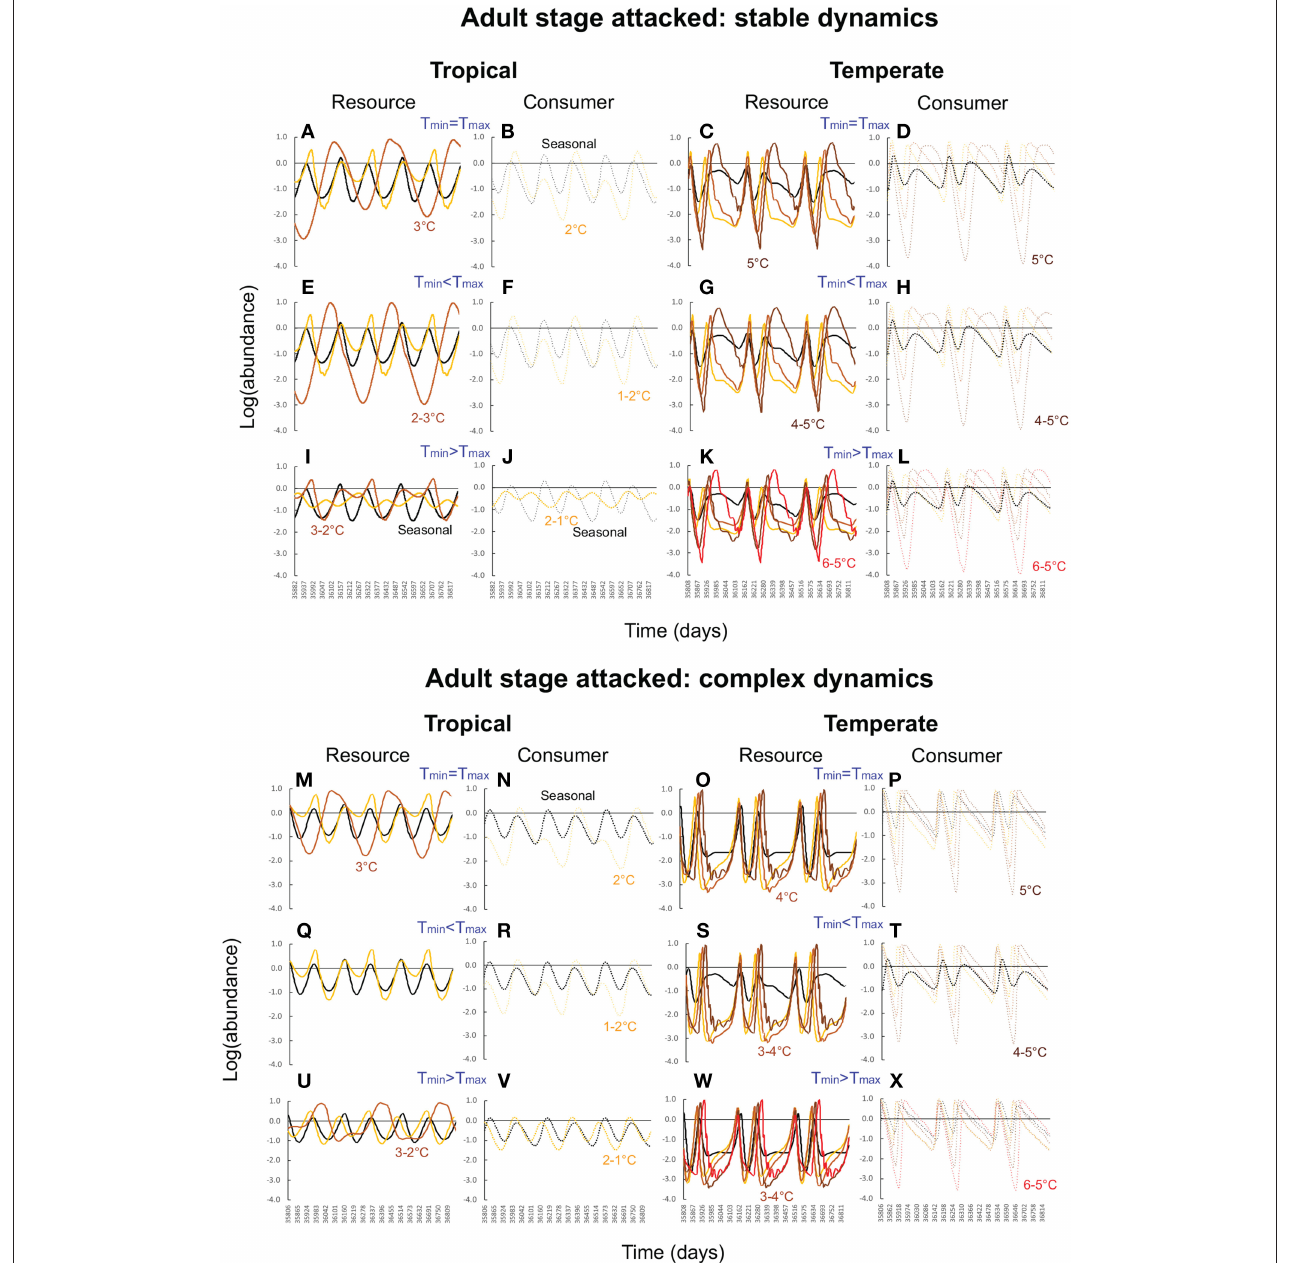
FIGURE 3 | Consumer-resource dynamics in tropical and temperate habitats when the consumer attacks the adult stage and consumer-resource dynamics are stable (A–L) vs. complex (M–X) . In all panels, the black curves (solid for resource, dashed for consumer) depict abundances under typical seasonal variation. Yellow, light brown, dark brown, and red curves depict progressively higher levels of warming (1–4 ◦ C for tropical habitats, 2–6 ◦ C for temperate habitats). For each latitude, the top row of panels depict effects of warming when the minimum and maximum temperatures increase at the same rate (mean increases, amplitude unchanged). The second row depicts warming effects when the maximum temperature increases faster than the minimum (mean and amplitude both increase), and the third row, when the minimum temperature increases faster than the maximum (mean increases, amplitude decreases). Parameter values for the tropical community are: = 2.0, m J = 0.07 ( τ J = 15), = 5.0, m J = 0.05 ( τ J = 20), d J = 0.1, d A = 0.05, a T = 1.0 for stable dynamics, and b T b T opt opt opt T R T R T R T R T R T R = 0.01, a T = 0.5 for complex dynamics. Parameter values for the temperate community are: = 0.05, d A = 0.01, m L = 0.1 ( τ L = 10), d L = 0.1, d C d J opt TR TR TR TR TR TR = 0.05 for stable dynamics, and = 0.1, a T = 0.5, m L = 0.1 ( τ J = 10), d L = 0.1, d C = 1.0, m J = 0.04 ( τ J = 25), d J = 0.1, d C b T opt opt TR TR TR TR TR TR TR TR = 0.05, m L = 0.1 ( τ J = 10) for complex dynamics. All other parameters = 0.01, d L = 0.1, d C = 1.0, m J = 0.05 ( τ J = 20), d J = 0.05, d R b T opt T R T R T R T R T R T R T R T R values are as in Table 1